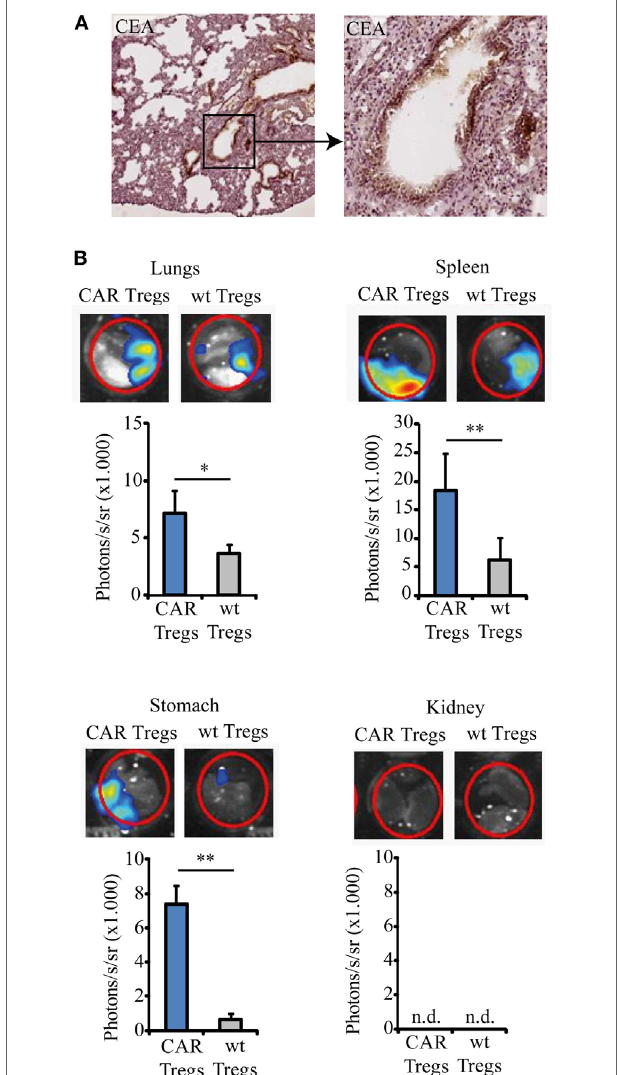
FigUre 2 | Chimeric antigen receptor (CAR) regulatory T cells (Tregs) home to the lung and spleen. (a) Lung slices from the carcinoembryonic antigen transgenic (CEAtg) mouse were stained for CEA (microscope magnifications 5 × and 20 × , respectively). CEA is expressed in a polarized fashion on the luminal site by the alveolar epithelia. (B) Gaussia Luciferase (Gluc)-labeled CAR Tregs and Gluc-labeled non-modified wild-type (wt) Tregs were recorded by bioluminescent imaging in the lungs, spleen, stomach, and kidney in the same mouse 36 h after Treg transfer to the ovalbumin-sensitized mice. One representative mouse out of three from each group is shown. Statistical analyses were performed using the Student’s t -test. * p < 0.05, ** p < 0.01; n.d., not